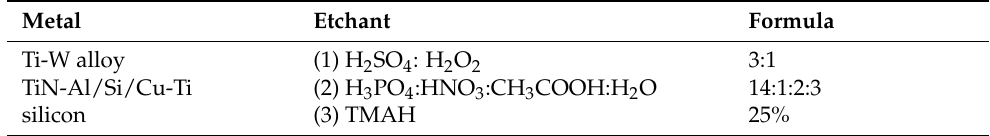
Table 2. Post etching recipe of CMOS